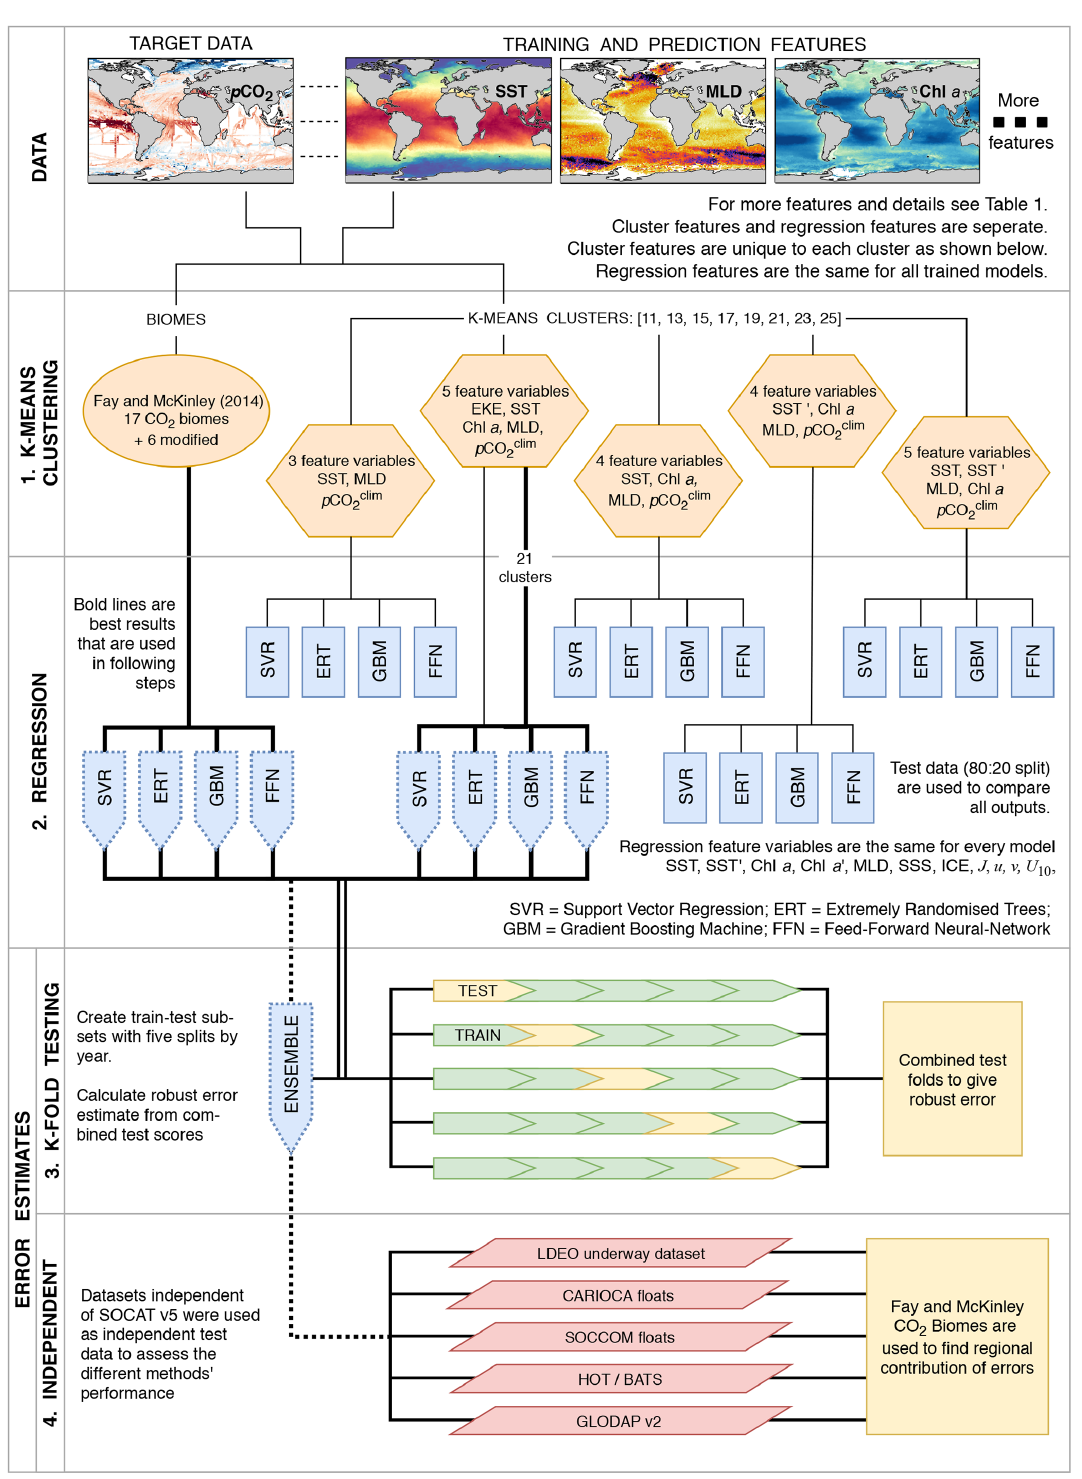
Figure 1. A flow diagram that shows the experimental procedure used in this study. Abbreviations for feature variables in the orange hexagons can be found in Table 1. All other abbreviations are given in the diagram. Details of each step are given in the text (Sect.